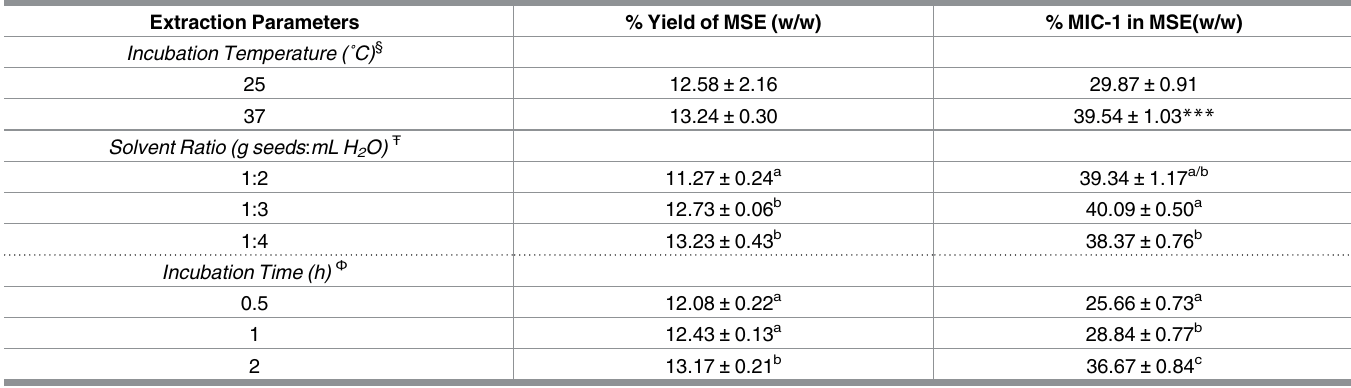
Table 1. Optimization of MSE for MIC-1